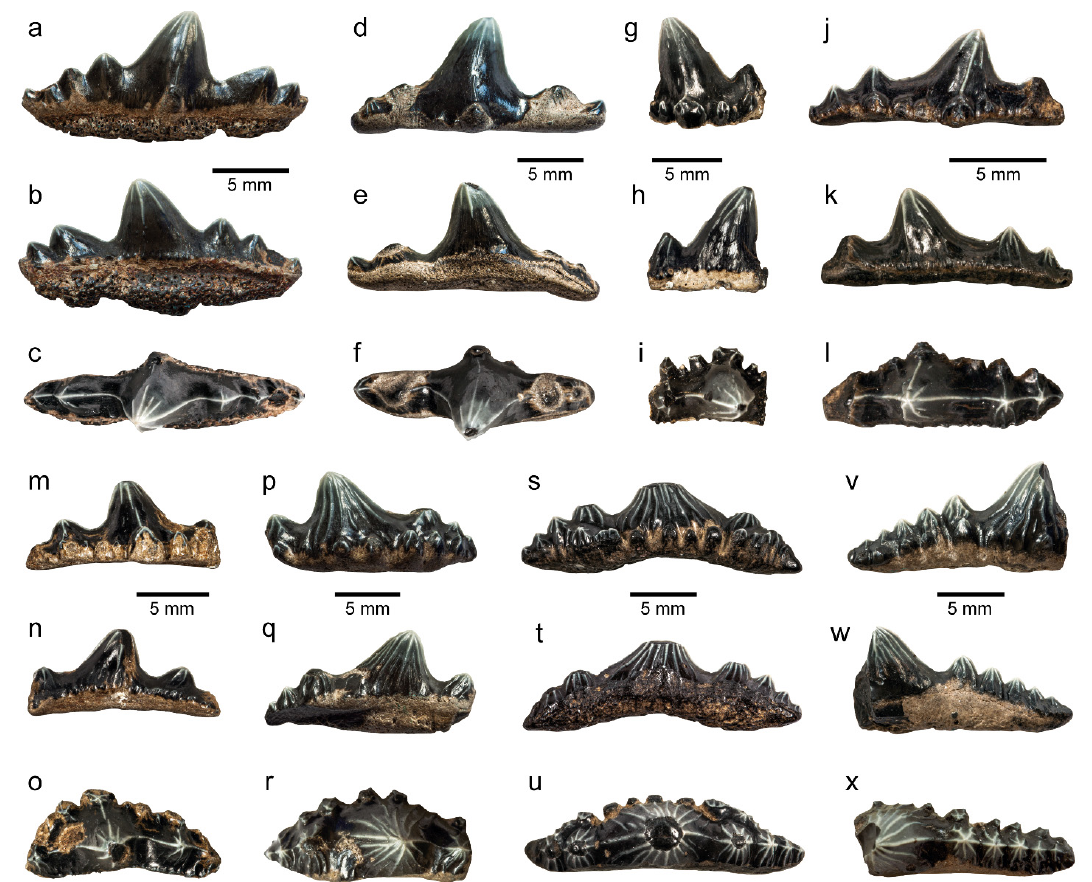
Figure 3. Historically collected hybodontiform teeth from the lower Kimmeridgian of Czarnogłowy, Poland. Asteracanthus ornatissimus Agassiz, 1837. GG 303/19 in ( a ) labial, ( b ) lingual and ( c ) apical view; GG 303/20 in ( d ) labial, ( e ) lingual and ( f ) apical view; GG 303/21 in ( g ) labial, ( h ) lingual and ( i ) apical aspect; GG 303/22 in ( j ) labial, ( k ) lingual and ( l ) apical view; GG 303/23 in ( m ) labial, ( n ) lingual and ( o ) apical view; GG 303/29 in ( p ) labial, ( q ) lingual and ( r ) apical view; GG 303/30 in ( s ) labial, ( t ) lingual and ( u ) apical aspect; GG 303/31 in ( v ) labial, ( w ) lingual and ( x ) apical view.